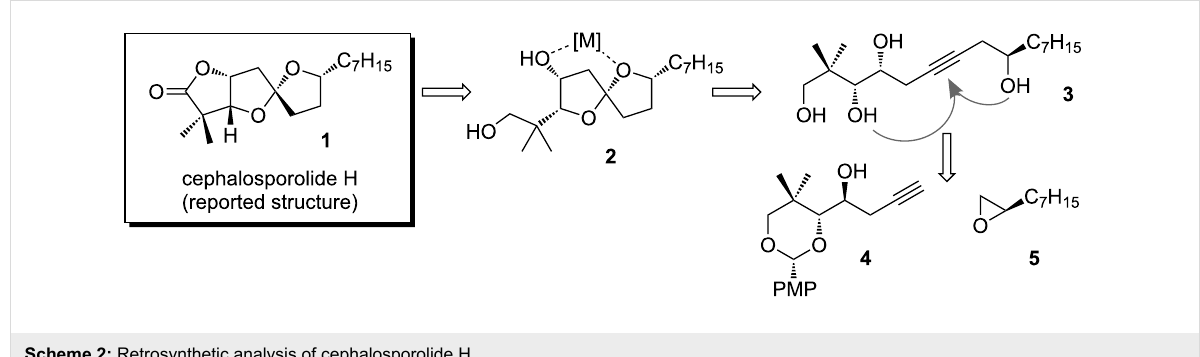
Scheme 2: Retrosynthetic analysis of cephalosporolide